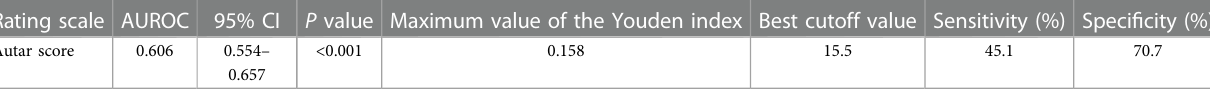
TABLE 3 ROC curve analysis results of Autar score in predicting DVT in patients with pelvic or lower-extremity